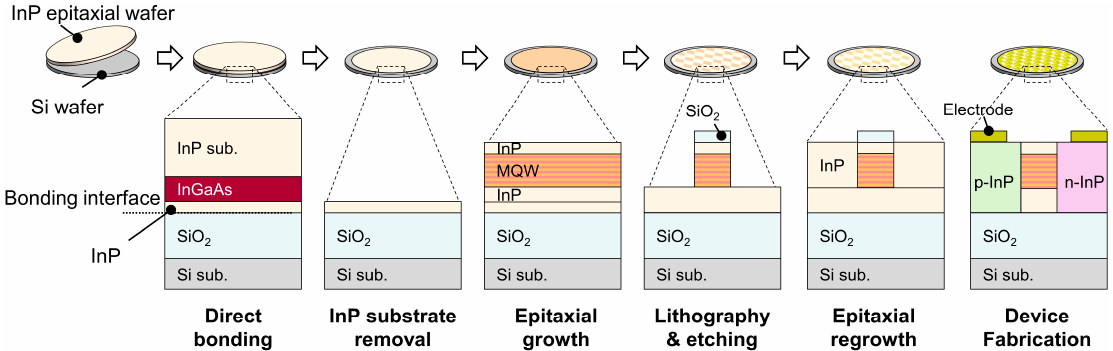
Figure 1. Process flow of fabricating membrane photonic devices on Si using epitaxial growth technique on a III ‐ V ‐ on ‐ insulator platform.